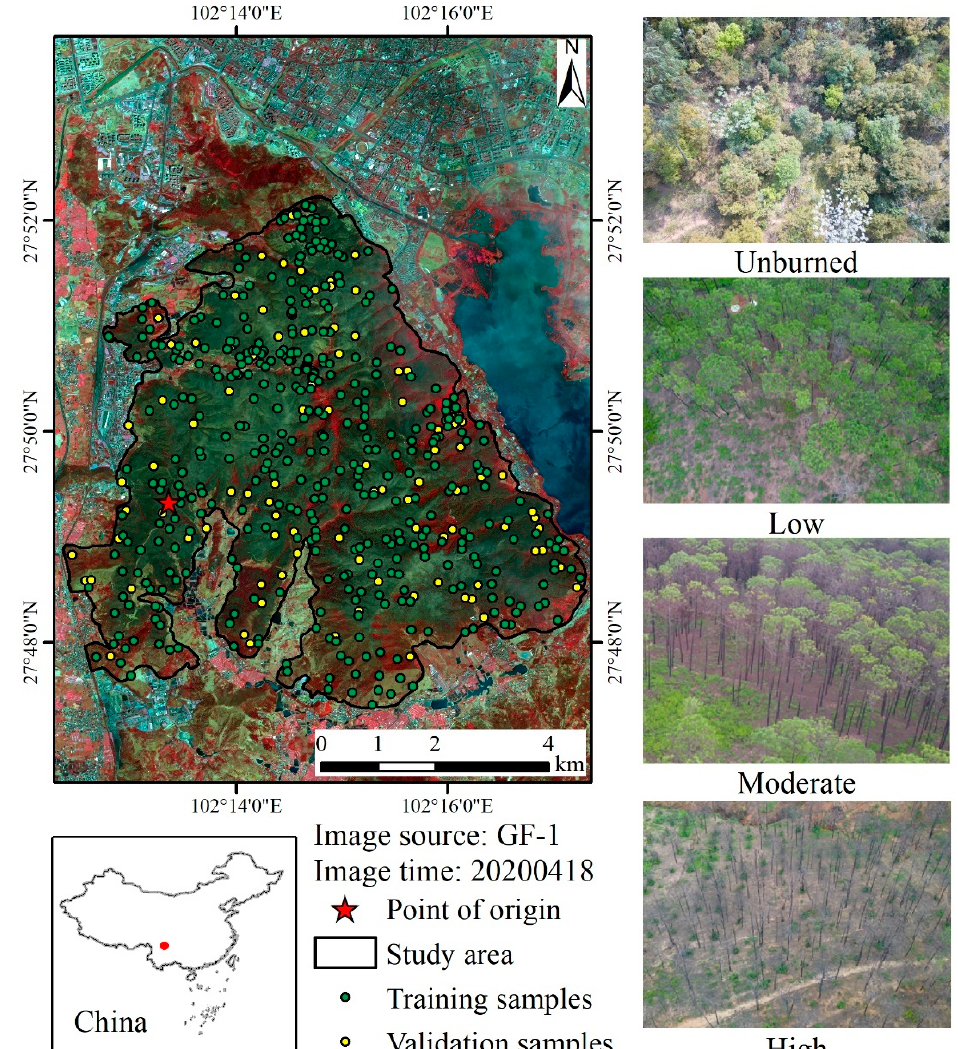
Figure 1. The location of the study area with field survey photos of different fire severity levels. The red dot indicates the location of the study area in China. The densely populated residential area of Xichang City, Liangshan Yi Autonomous Prefecture (Sichuan Province, Southwest China), is adjacent to the northern part of the study area. Due to the government’s restrictions on entering the mountain after the fire, the field photos of different fire severity classes were taken in July. The burnt understory grass had re-sprouted three months after the fire in July. Burn marks can be seen on the ground and tree trunks can be seen in the low severity field photo. Most of the canopy (>50%) was scorched in the moderate severity field photo. Full canopy biomass was consumed in the high severity field photo.